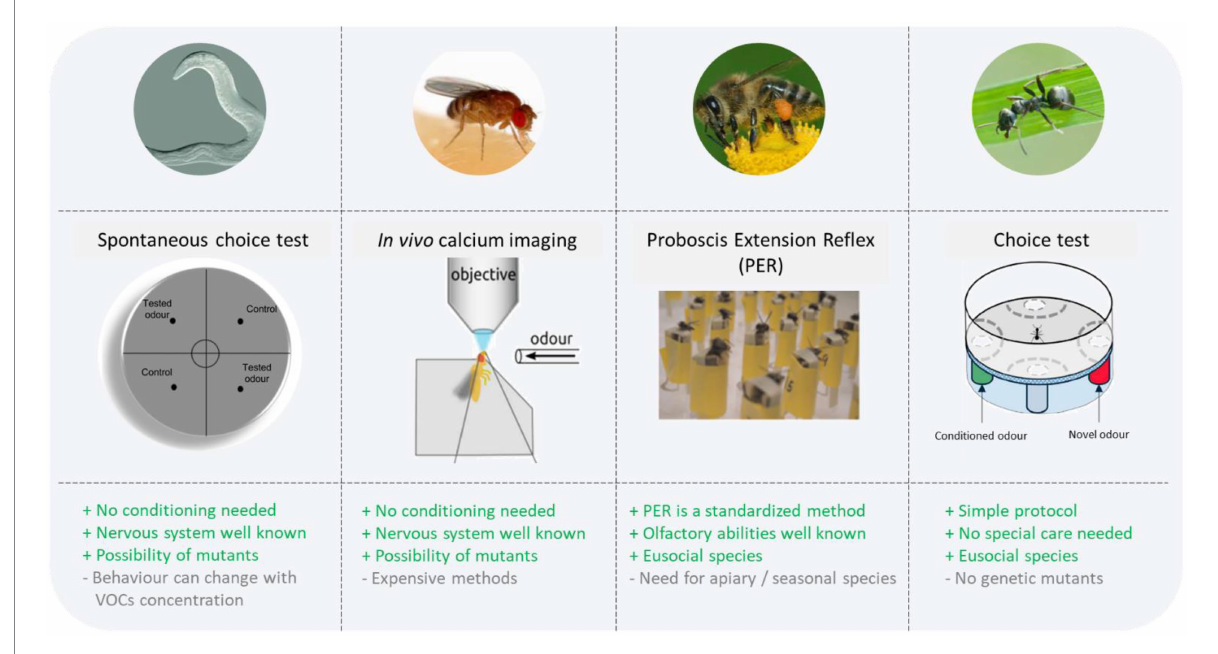
FIGURE 1 Advantages and constraints of the invertebrate species for disease detection. The four species already tested – the nematode Caenorhabditis elegans , the fly Drosophila melanogaster , the bee Apis mellifera , and the ant Formica fusca – are presented together with the method used, as well as with the advantages and current constraints of these species for disease detection. Pictures for the methods are adapted from Giurfa and Sandoz (2012), Strauch et al. (2014), Thompson et al. (2021), Piqueret et al.